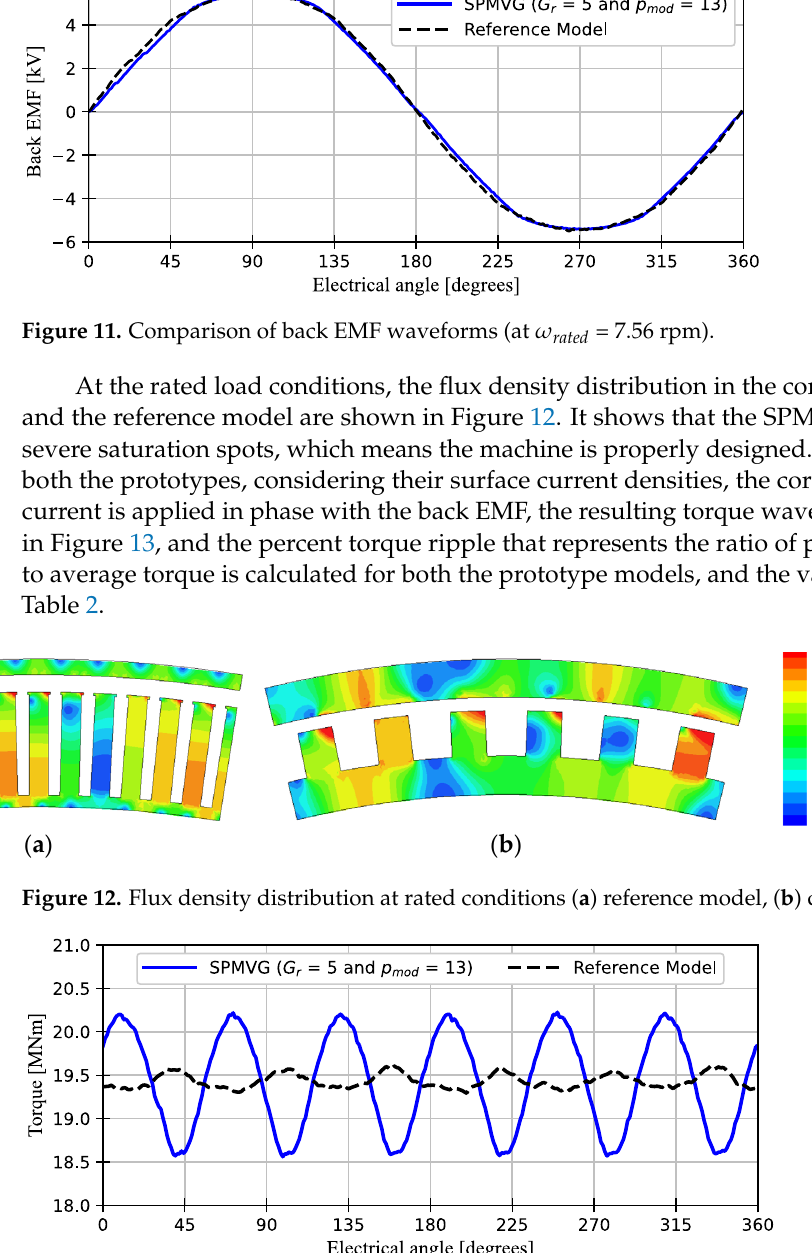
Figure 10. No-load flux lines ( a ) reference model, ( b ) designed SPMVG. Figure 11. Comparison of back EMF waveforms (at ω rated = 7.56 rpm). Table 2. Performance Summary.